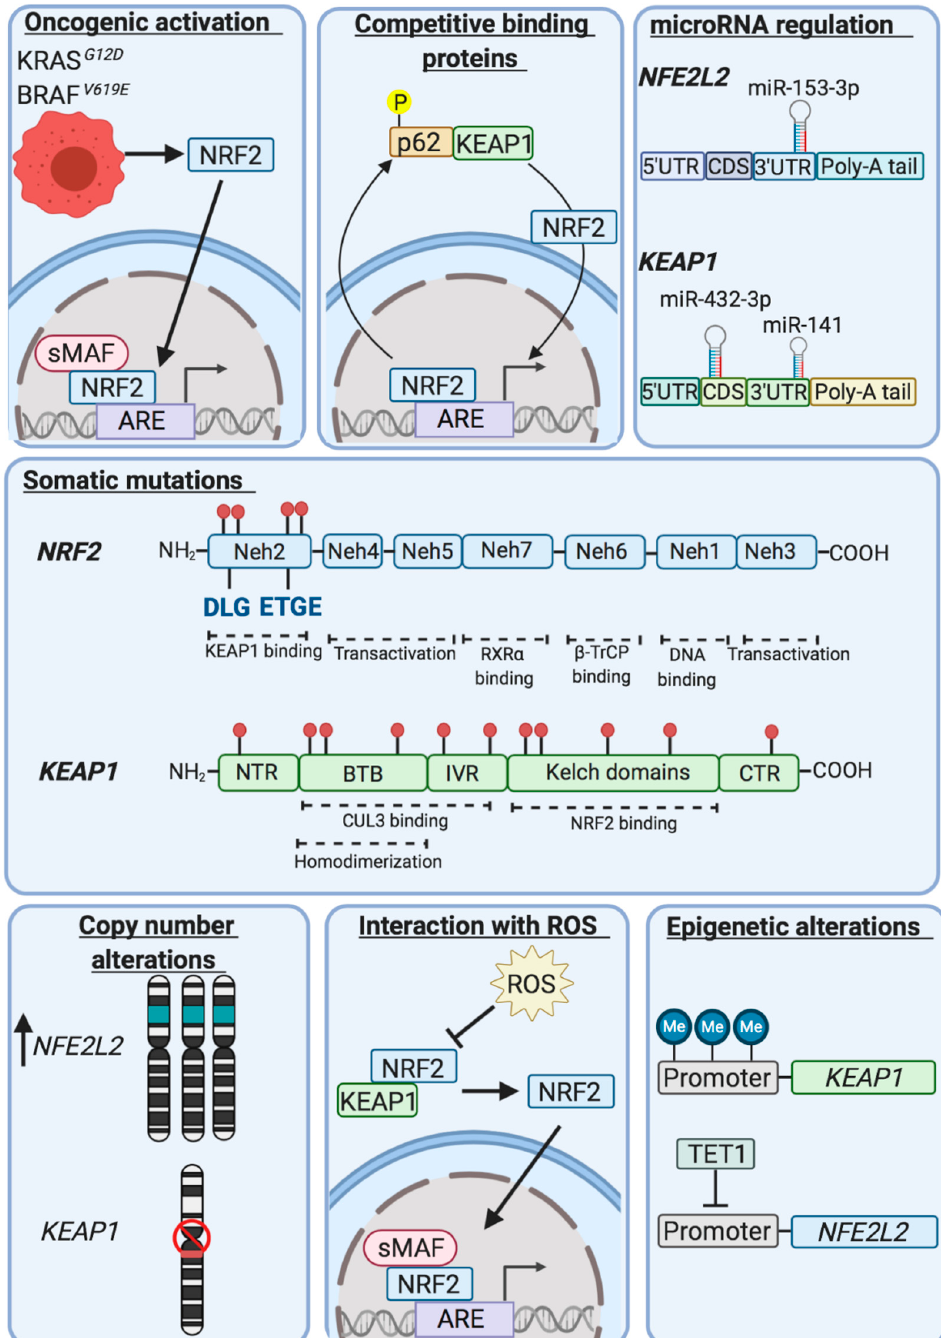
Figure 5. Mechanisms of upregulation of NRF2 in tumours. The cartoon shows the various ways in which NRF2 activity can be upregulated in cancer. The top left-hand panel shows how NRF2 activity can be increased by oncogenic proteins: the middle top panel shows how p62 / SQSTM1 binds to KEAP1, thereby preventing KEAP1 from repressing NRF2; the top right-hand panel indicates how microRNAs can increase NRF2 activity through interacting with either NFE2L2 or KEAP1 transcripts. The center panel illustrates regions of KEAP1 and NFE2L2 that are frequently somatically mutated in cancer (with mutations represented by red circles). The bottom left-hand panel depicts how NRF2 abundance can be enhanced by increases in NFE2L2 copy number or decreases in KEAP1 copy number; the bottom center panel depicts how interaction with ROS oxidize cysteine residues in KEAP1 preventing it from targeting NRF2 for proteasomal degradation; the bottom right-hand panel highlights how epigenetic alterations in KEAP1 and NFE2L2 impact NRF2 abundance.